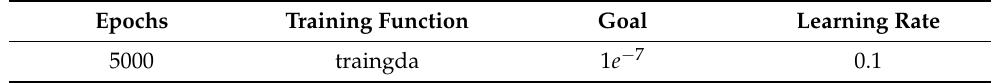
Table 1. The parameters of BPNN.